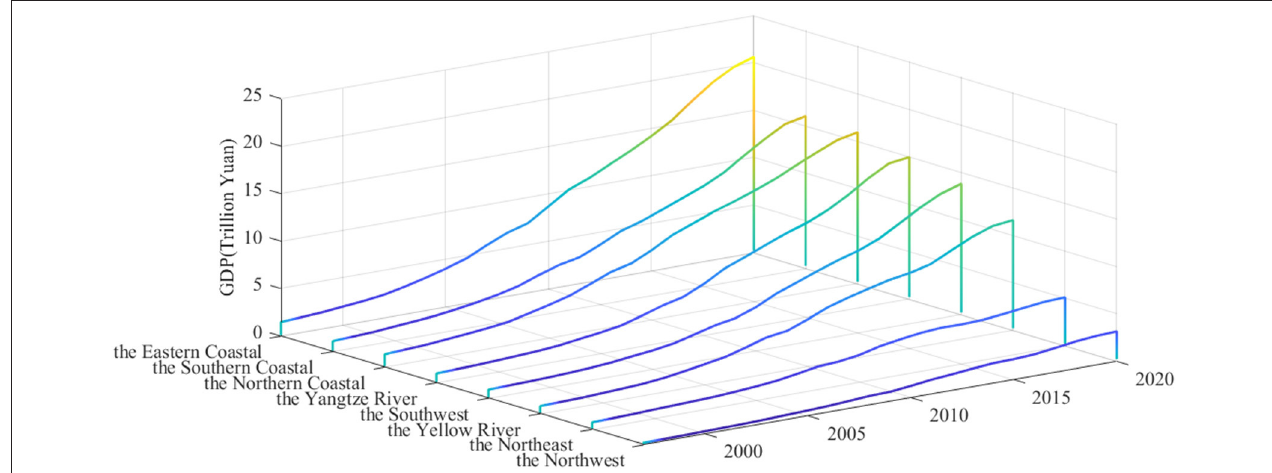
FIGURE 1 | GDP trend of eight major economic zones in mainland